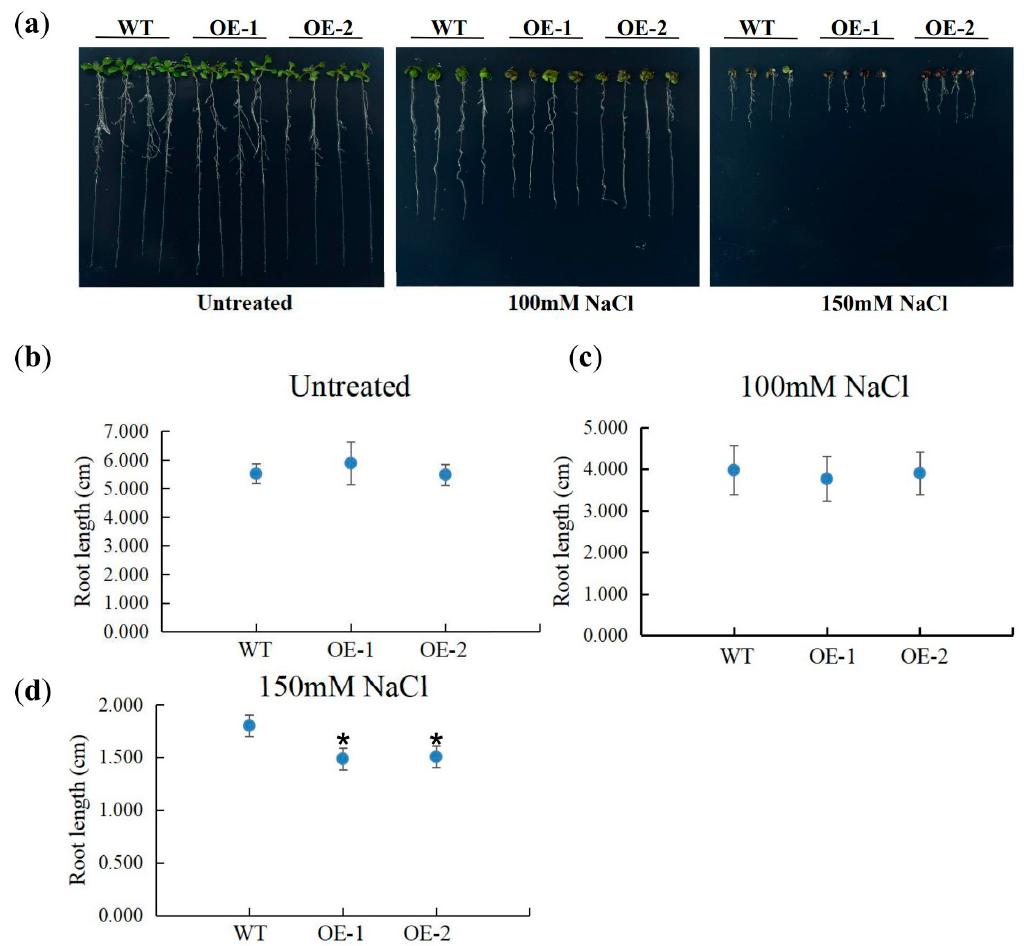
Figure 8. Phenotypic comparison of wild-type (WT) and AcYABBY-over-exression ( AcYABBY-OE ) Arabidopsis seedling under salt treatment. ( a ) Seedlings grown on 1 / 2 MS medium for three days were transferred to 1 / 2 MS medium supplemented with NaCl or without NaCl and allowed to grow for additional seven days. ( b ) Comparative root lengths of WT and transgenic lines in control conditions. ( c ) Comparative root length between WT and transgenic lines under 100mM NaCl treatment. ( d ) Comparative root lengths of WT and transgenic lines under 150 mM NaCl treatment. * denotes the significant di ff erence (* p < 0.05) of t-tests between the transgenic lines and wild type.